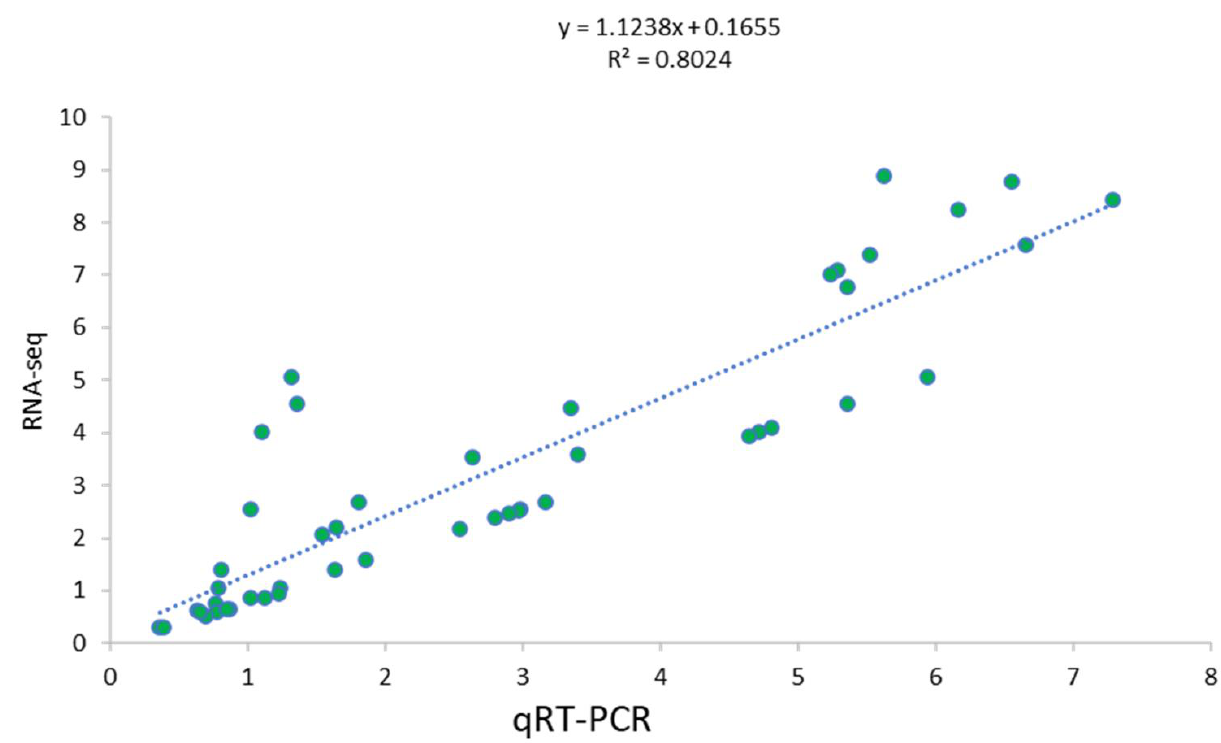
Figure 5. Correlation between gene expression patterns based on qRT-PCR and RNA-seq from randomly selected differentially expressed genes related to salt stress tolerance. The equation shows the regression line. The intercept of 0.1655 is the value of y when x = 0. The slope of 1.1238 measures the change in y for a one-unit increase in x. R 2 is the coefficient of correlation between qRT-PCR and RNA-seq expression values.